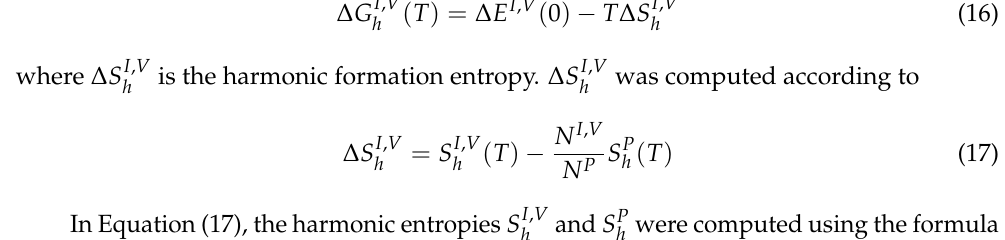
Figure 2. The integrands at different green for Tersoff. The lines are guides for eyes.